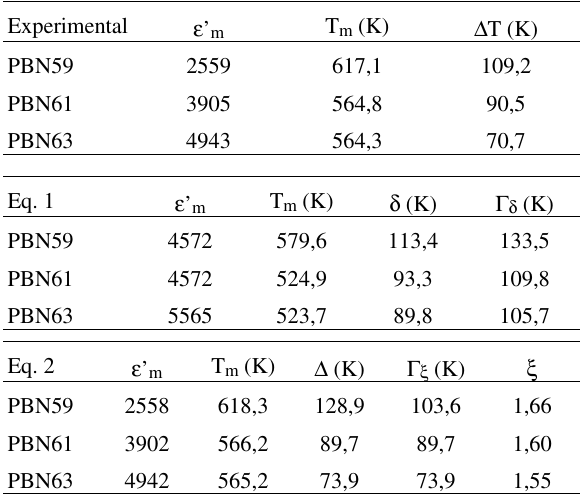
parâmetros físicos ( ε ’ m e T m ) obtidos através da Eq. 2 também apresentam uma melhor concordância com os